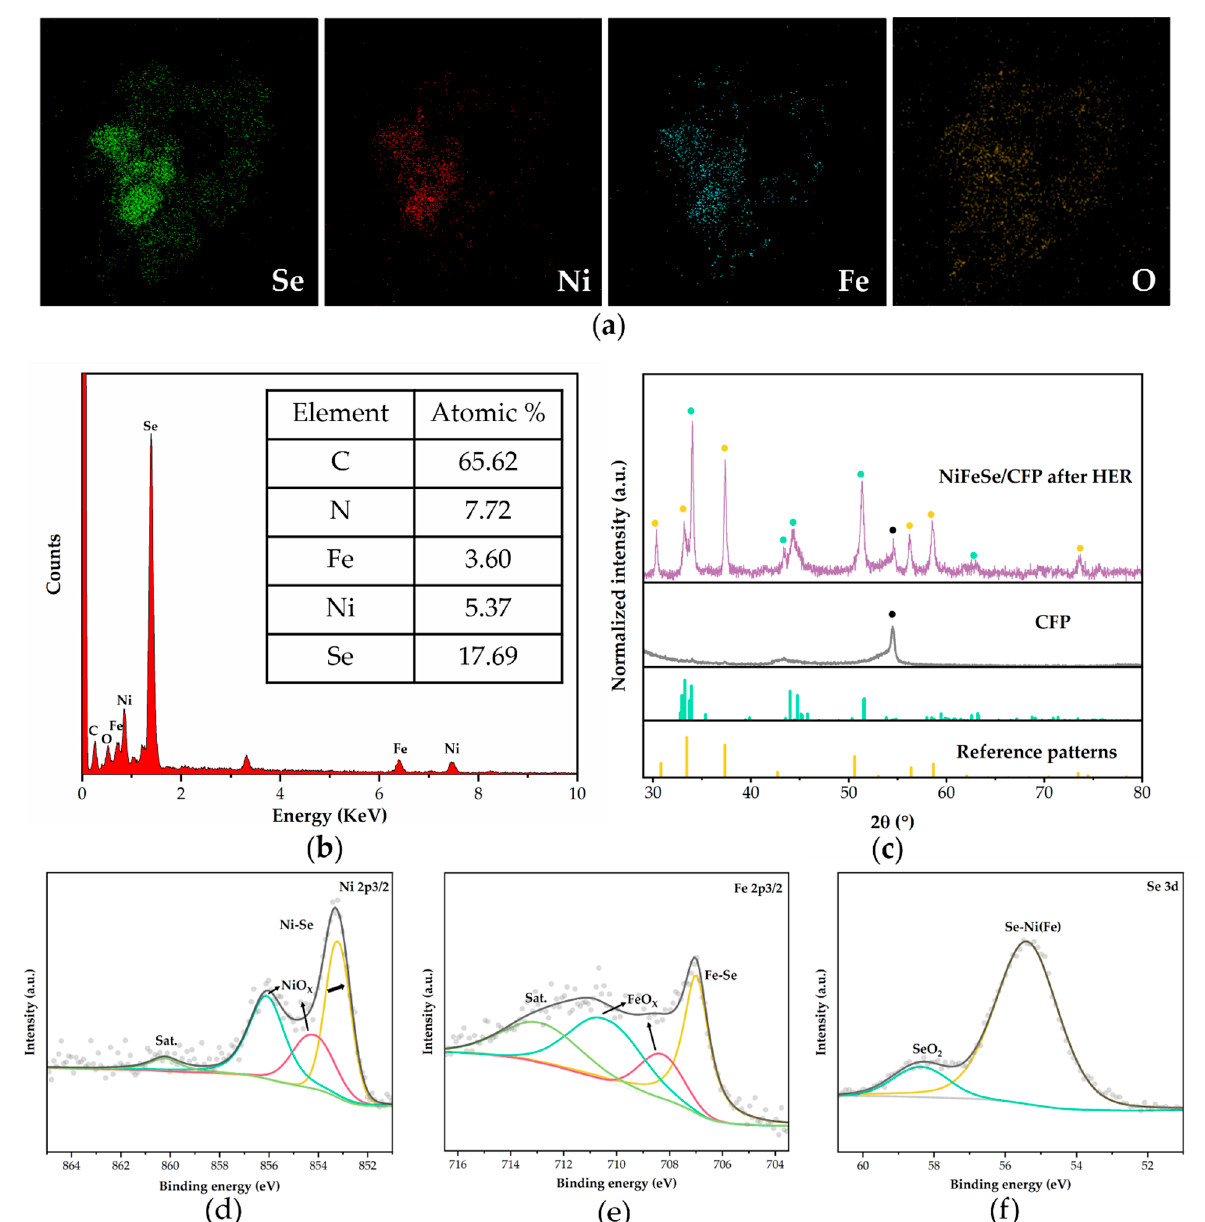
Figure 5. Composition and structure characterizations. ( a ) Elemental mapping images and ( b ) EDS spectrum in FESEM of selected NiFeSe/CFP after HER stability test. ( c ) XRD spectra of NiFeSe/CFP and the reference patterns of NiSe 2 (yellow, ICDD: 04-003-1991), Fe 2 NiSe 4 (cyan, ICDD: 01-089-1968). The peaks marked with black dots correspond to CFP substrate. XPS spectra of ( d ) Ni 2p, ( e ) Fe 2p and ( f ) Se 3d in